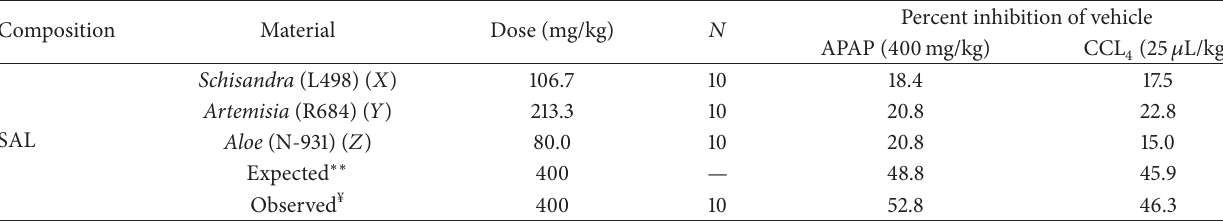
Table 2: Unexpected synergistic effect of Schisandra chinensis , Artemisia capillaris, and N-931 in liver protection. Composition